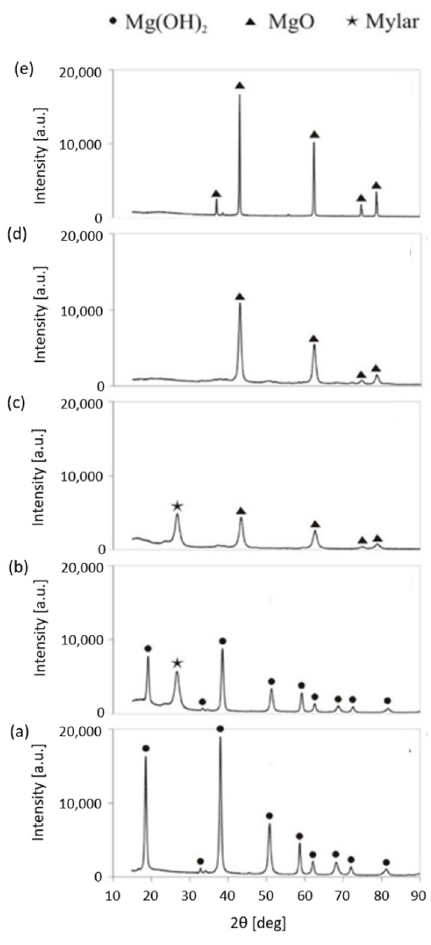
Figure 2. XRD results obtained for ( a ) MgO-473, ( b ) MgO-573, ( c ) MgO-673; ( d ) MgO-873 and ( e ) MgO-1873.